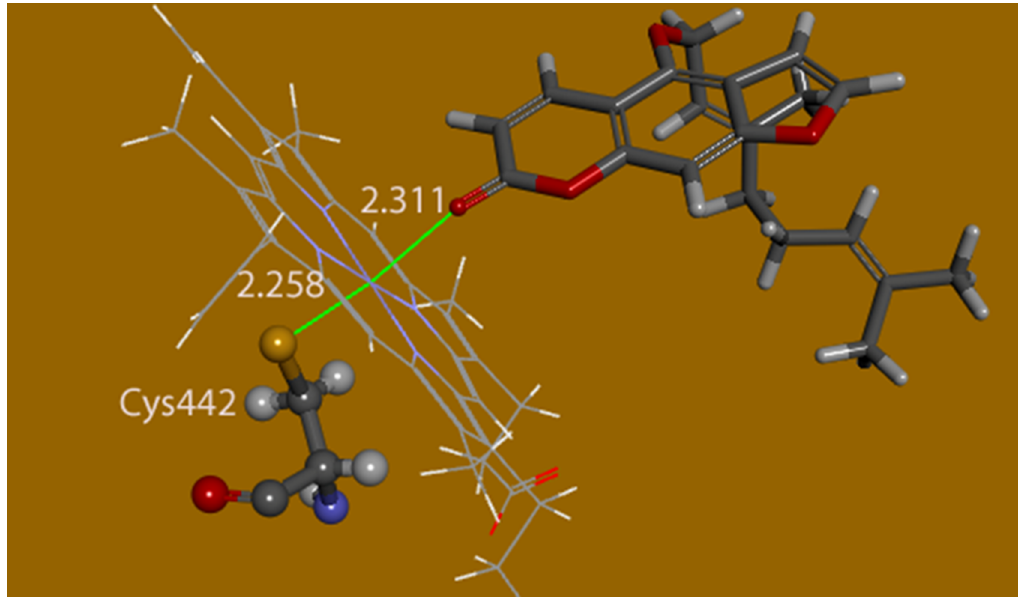
Figure 9. 2D Docking of bergamottin pose 5 displaying an octahedral Fe configuration, having the same heme projection as Figure 7 shown earlier.